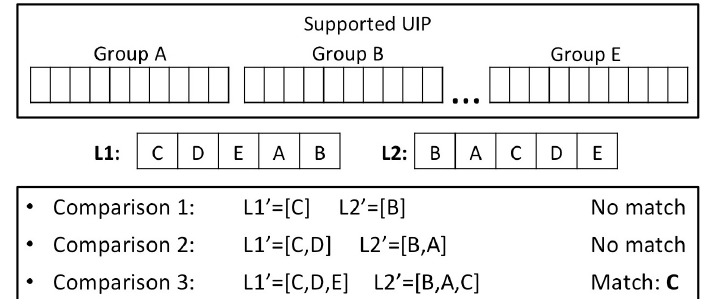
Figure 4. Example of algorithm for User’s Interest Profile (UIP)